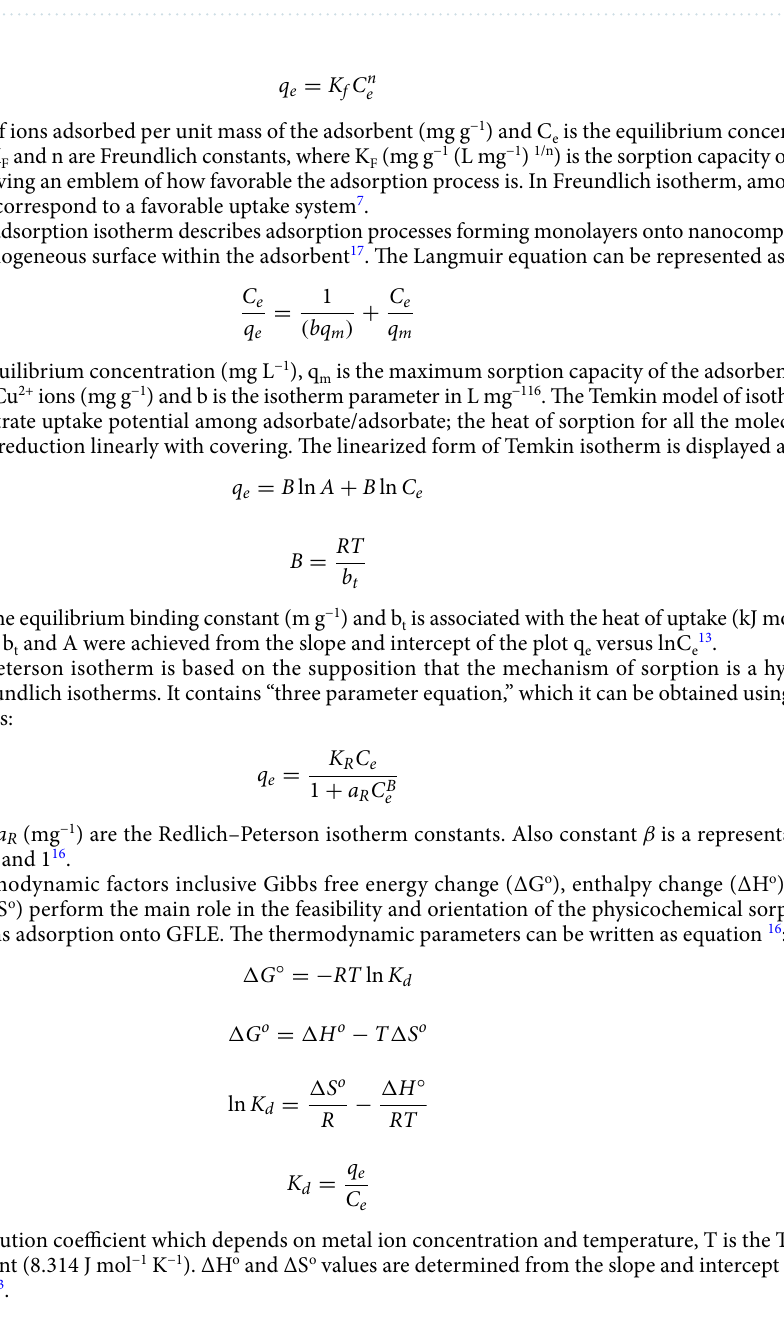
Table 2. Numerical equations in Cu (II) uptake